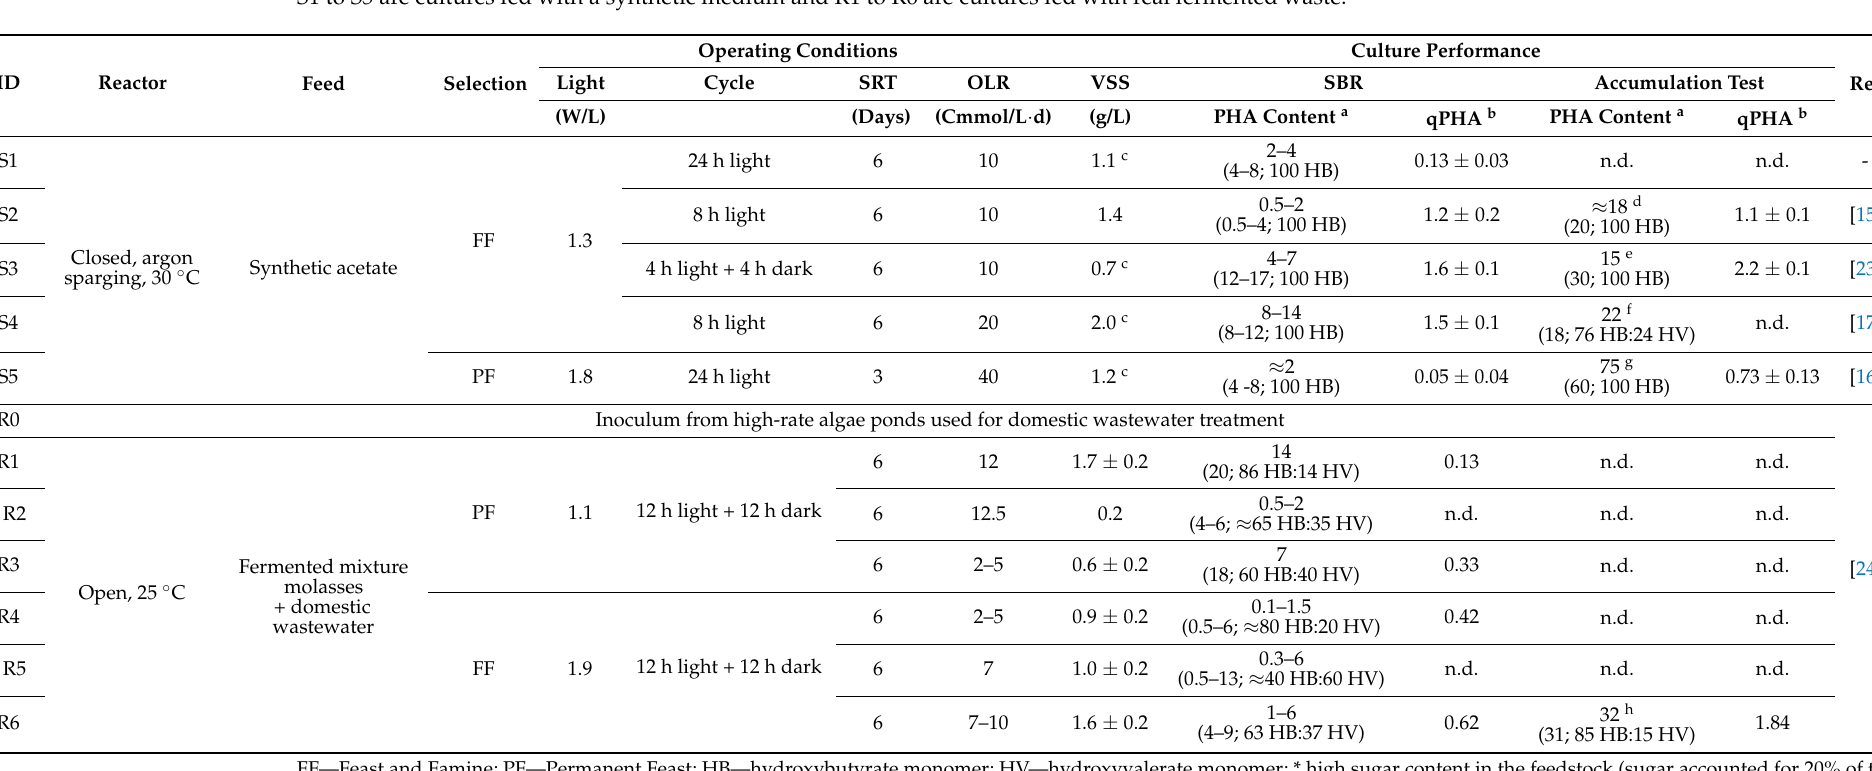
Table 1. Summary of the operating conditions of the PHA-producing PMCs investigated in this study and corresponding biomass and PHA production performance. S1 to S5 are cultures fed with a synthetic medium and R1 to R6 are cultures fed with real fermented